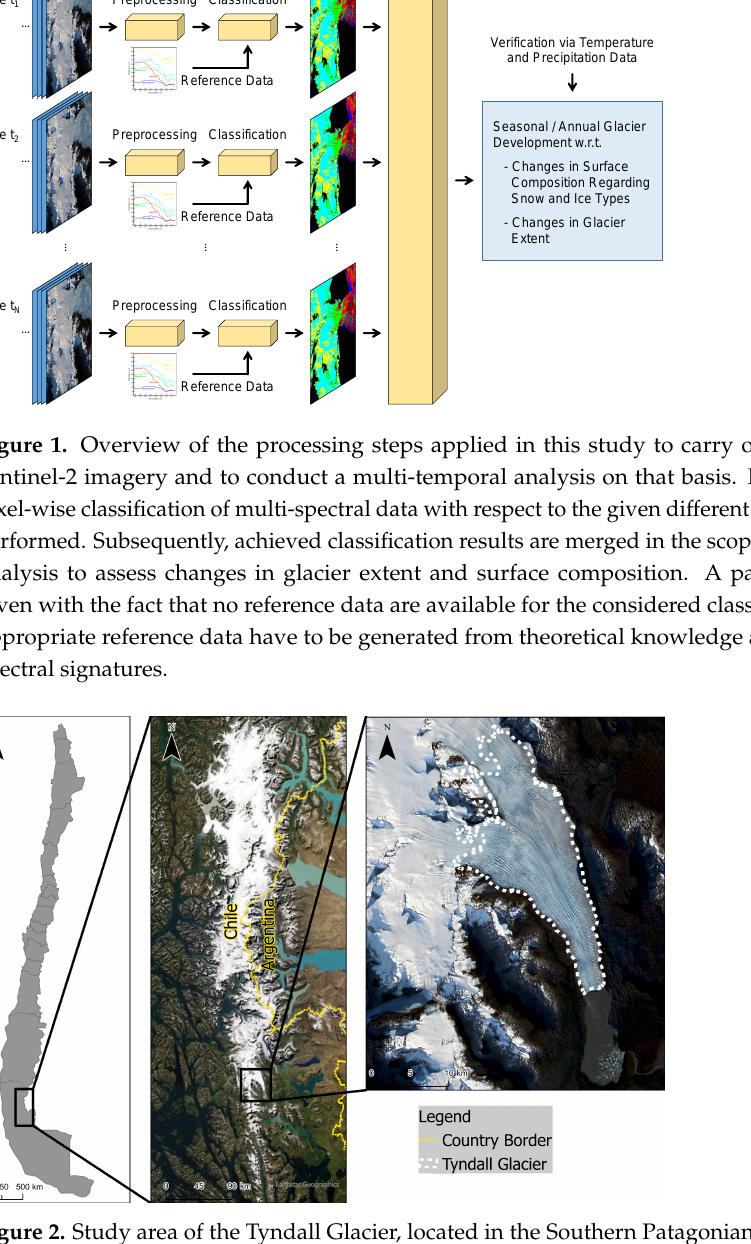
Figure 2. Study area of the Tyndall Glacier, located in the Southern Patagonian